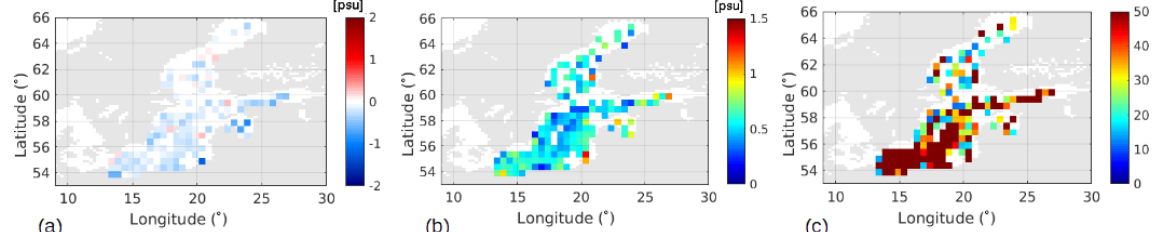
Figure 21. Comparison of L4 SSS and SDN, spatial distribution of (cid:49) SSS [psu] (0 . 5 ◦ grid): (a) mean, (b) standard deviation, (c) number of